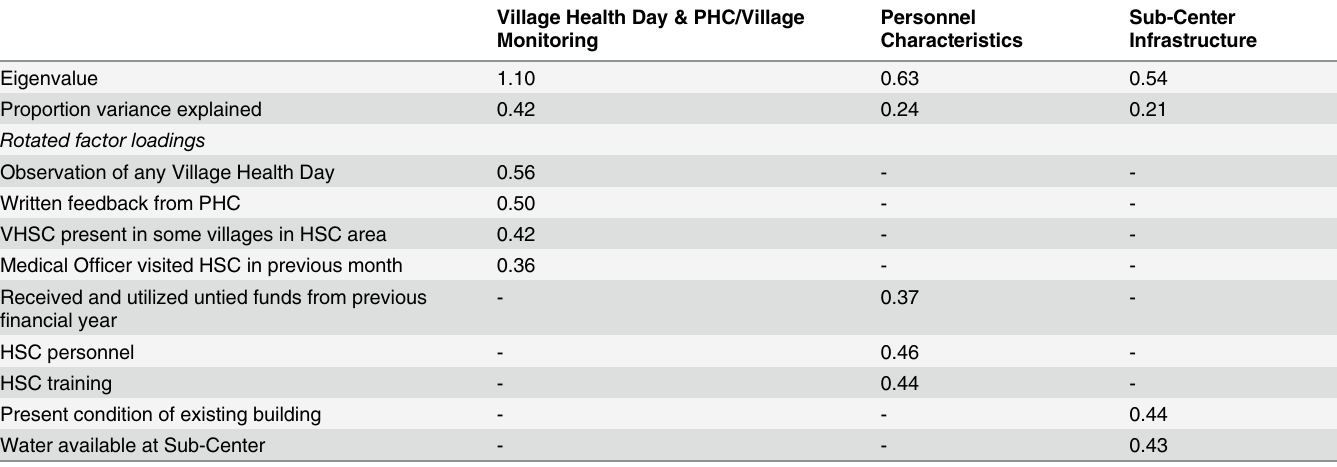
Table 2. Characteristics and rotated factor loadings for Health Sub-Center factorsa a